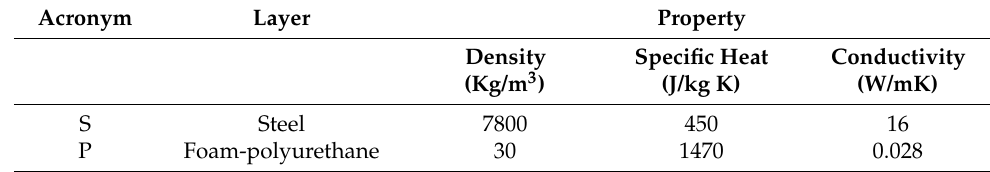
Table 5. Modeling construction materials and properties used for the building simulation.